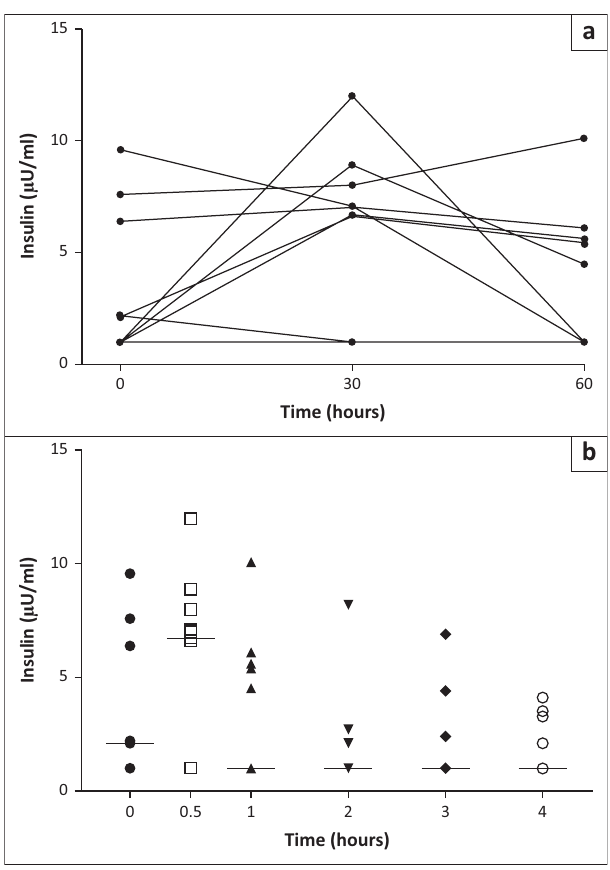
FIGURE 5: Insulin responses to PF. (a) Individual insulin changes (from baseline) at 30 min and 60 min. The magnitude of insulin change at 30 min ranged from -2.5 µ U/ml to +11.0 µ U/ml. (b) Scatter plot (line at median) of insulin levels at baseline (fasting) and across the 4-h study period. Median (95 % CI) insulin after 30 min had increased from 2.1 µ U/ml (1.0 µ U/ml–7.6 µ U/ml) to 6.7 µ U/ml (1.0 µ U/ml–8.9 µ U/ml). However, this change was not significantly different (Wilcoxon signed rank test, p = 0.2).